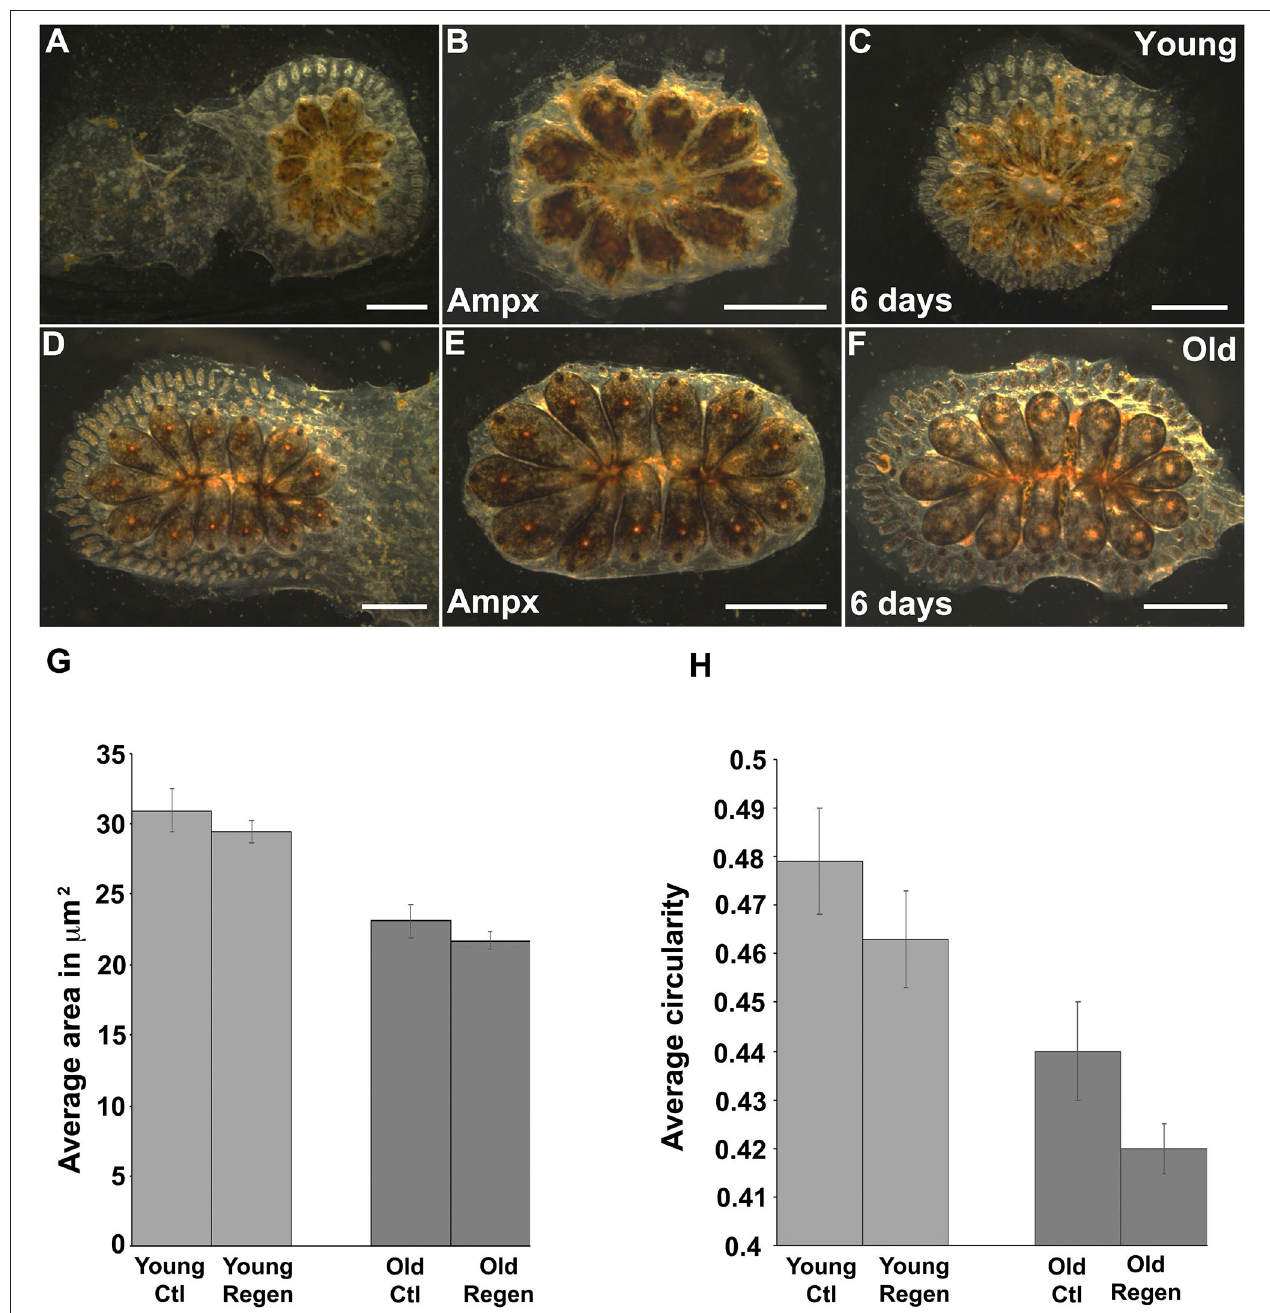
FIGURE 7 | Cytoskeleton changes on aged vascular cells retained the same phenotype upon regeneration. (A–C) Young colony before and after ampullectomy and fully regenerated 6 days later. (A) Representative bright field images of young colony before surgery. (B) Bright field image of a young colony immediately following ampullectomy (Ampx) and (C) Bright field image of a young colony 6 days post-ampullectomy with fully regenerated vessels. (D–F) Old colony before and after ampullectomy and fully regenerated 6 days later. (D) Representative bright field images of old colony before surgery. (E) Bright field image of an old colony immediately following ampullectomy and (F) Bright field image of an old colony 6 days post ampullectomy with fully regenerated vessels. (G,H) Regenerated blood vessels were stained with Pan-Cadherin and the (G) average area and (H) circularity of cells in control (Ctl) and regenerated (Regen) tissue for both young and old animals. Statistical analysis was performed using the Student’s t -test. Scale bars: